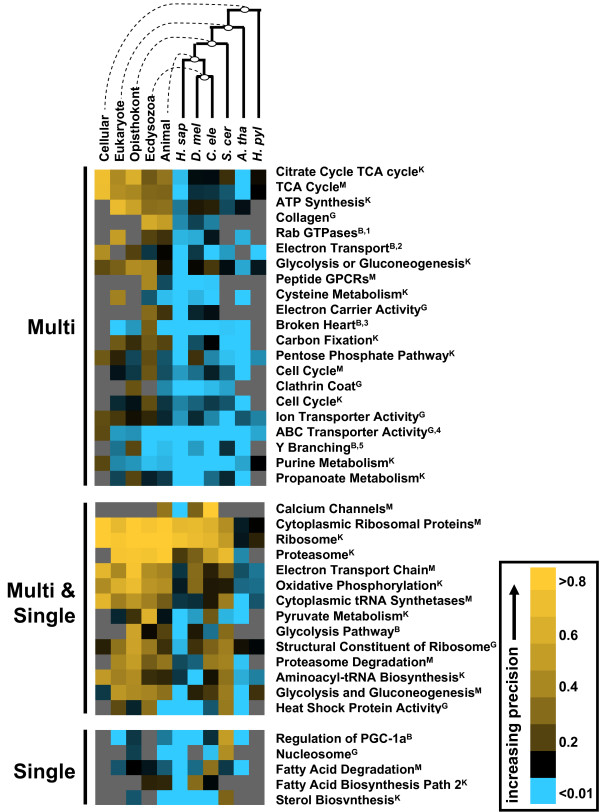
Pathways with precise search results. The precision obtained at every PMT search node is shown for pathways that achieved a precision of at least 20% in one or more nodes of the PMT at the 50% recall rate. Yellow corresponds to high precisions near 100%, and blue to low precisions near 0%. The first 21 rows (Multi) correspond to pathways for which a precision of at least 20% was achieved only by a multiple-organism node. The next 14 rows (Multi & Single) correspond to pathways for which both multiple- and single-organism nodes achieved a precision of at least 20%; the last five rows (Single) correspond to pathways for which only a single-organism node achieved a precision of at least 20%. Superscript letters indicate the database from which pathways were collected: K, KEGG [14]; G, GO [13]; M, GenMAPP [12]; B, BioCarta [34]. Superscript numbers indicate pathway names that were abbreviated: 1, Rab GTPases Mark Targets in the Endocytotic Machinery; 2, Electron Transport Reaction in Mitochondria; 3, NFAT and Hypertrophy of the Heart Transcription in the Broken Heart; 4, ATP-Binding Cassette ABC Transporter Activity; 5, Y Branching of Actin Filaments.